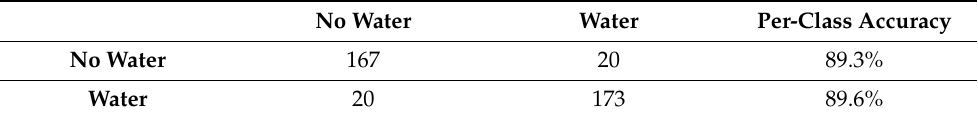
Table 6. Confusion matrix for the proposed CNN+LSTM model onboard Nvidia Jetson TX2.